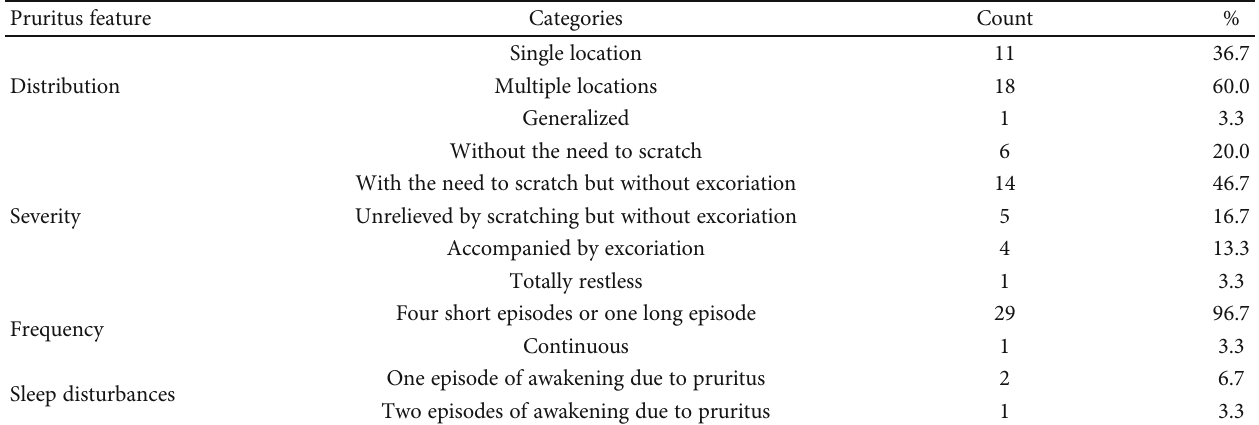
Table 2: Pruritus features of patients enrolled in the study.